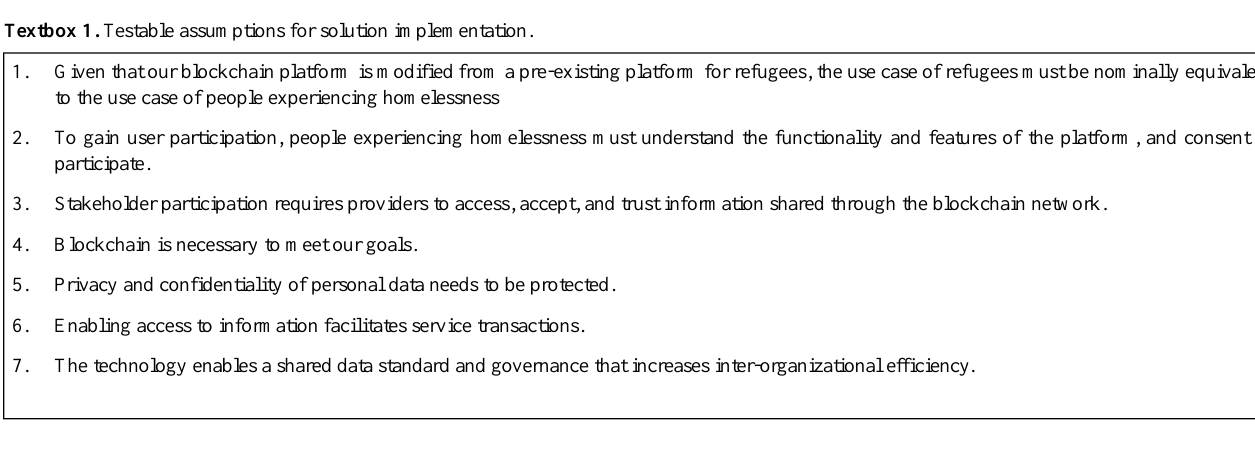
Table 1. Blockchain components needed for a successful prototype.